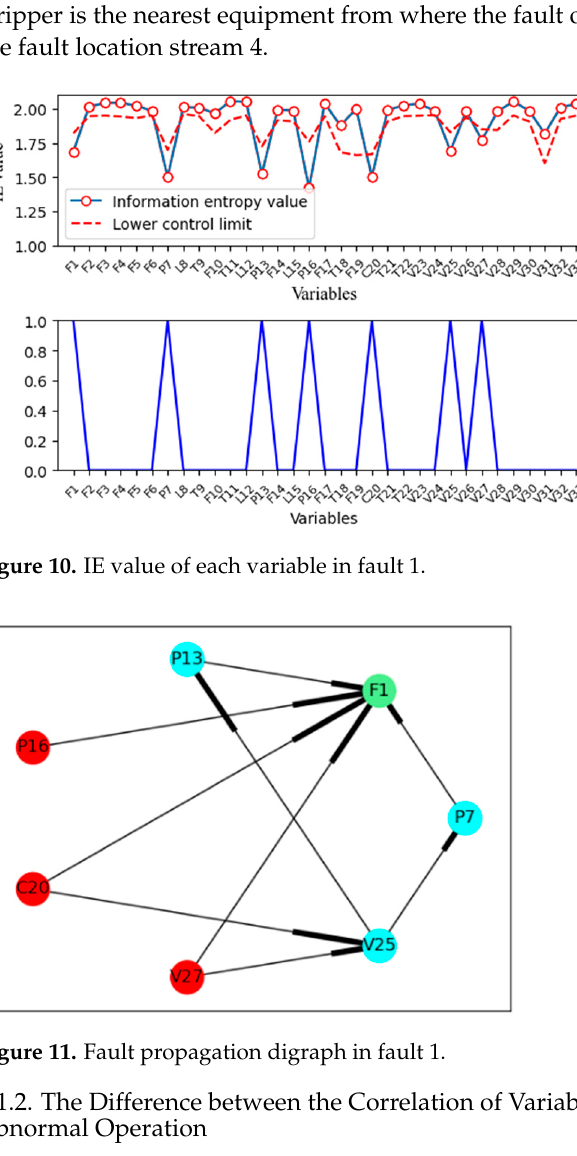
Figure 11. Fault propagation digraph in fault 1.